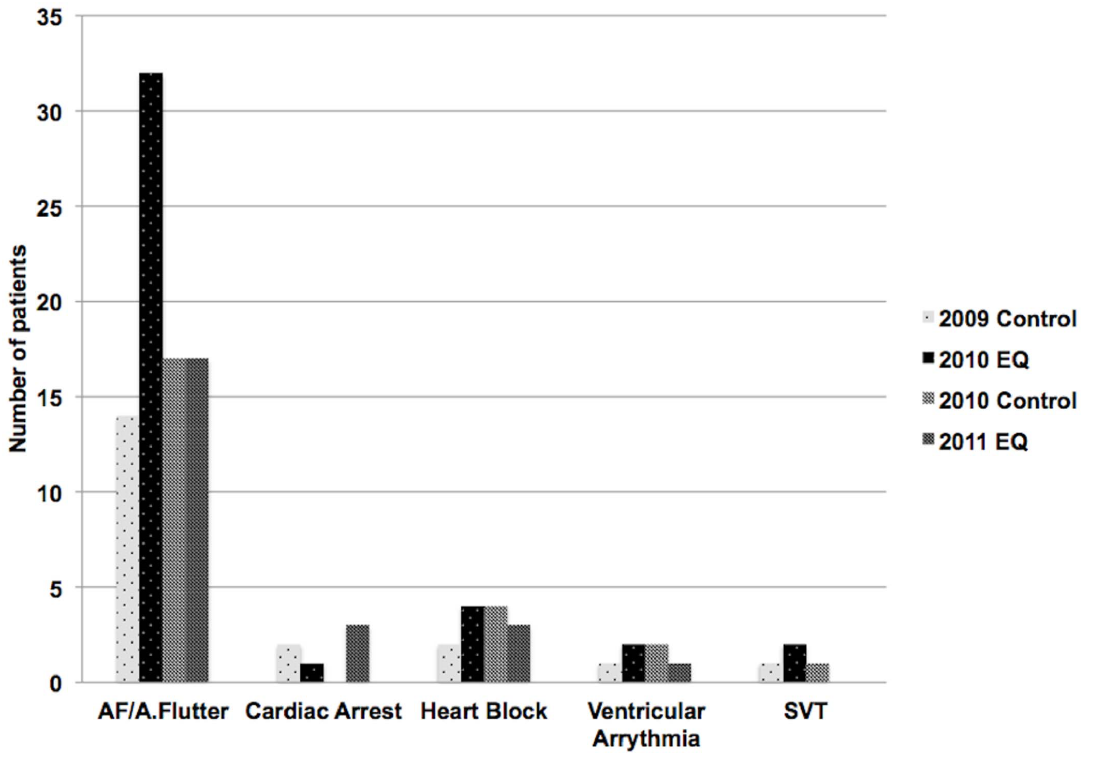
Figure 5. Arrhythmia presentations in the first 2 weeks following both earthquakes. AF = atrial fibrillation; A.Flutter = atrial flutter; SVT = supraventricular